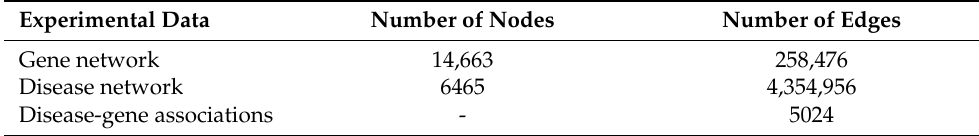
Table 2. Numbers of nodes and edges in each network for the experiment. Experimental